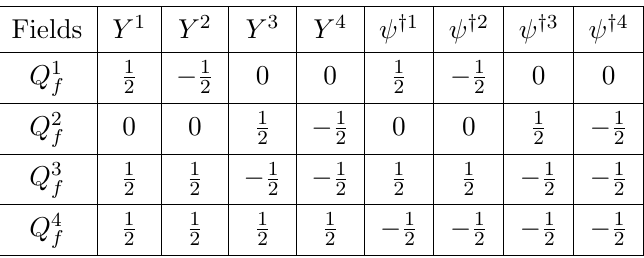
Table 2 . Charges of (cid:12)elds under four U(1)